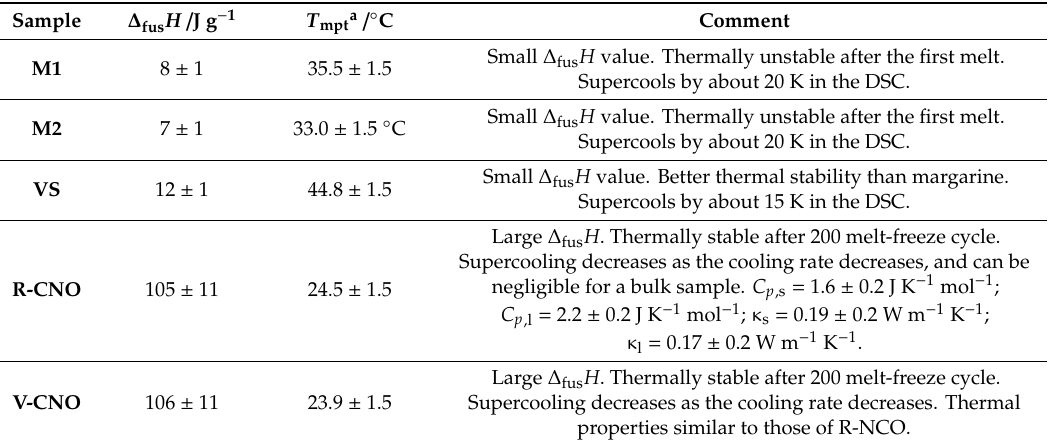
Table 3. Summary of the thermal properties results obtained for the edible oils investigated in this study.